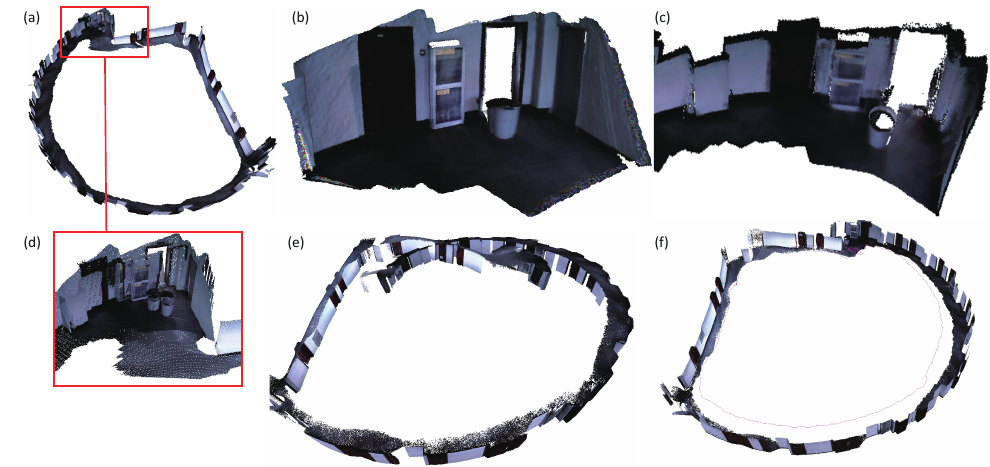
Figure 9. Comparison of the reconstruction results on the third-floor sequence. ( a ) is produced by Kintinuous [36]. The surfaces generated around the loop closure are misaligned as displayed in ( d ). ( b ) is generated by BundleFusion [33]. BundleFusion failed and produced an unsatisfactory result. ( c ) is produced by InfiniTAM v3 [39]. The system also failed. ( e ) is yielded by ElasticFusion [11,12]. ( f ) is produced by our system.